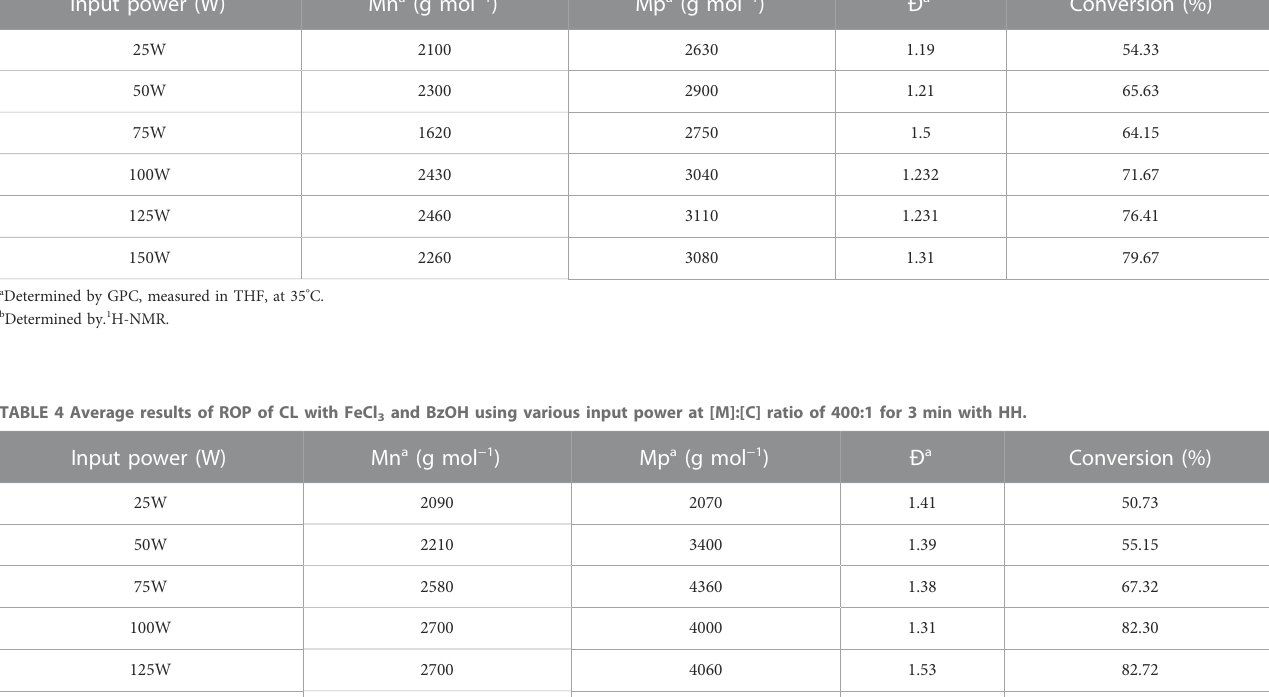
TABLE 3 Average results of ROP of CL with FeCl 3 and BzOH using various input power at [M]:[C] ratio of 400:1 for 3 min with EH. Input power (W)